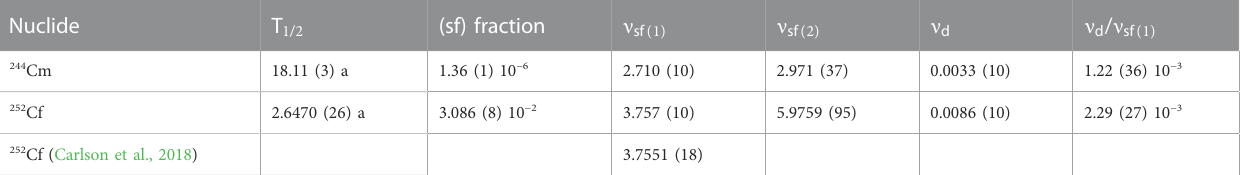
TABLE 9 Half-lives (DDEP, 2023), fraction for spontaneous fi ssion (DDEP, 2023), normalised factorial moments derived from the multiplicity distribution of the prompt fi ssion neutrons for 244 Cm(sf) and 252 Cf(sf) in Santi and Miller (2008) and delayed neutron emission data from Nichols et al. (2008). The average total number of prompt fi ssion neutrons for 252 Cf(sf) resulting from the neutron standards project (Carlson et al., 2018) is also given.